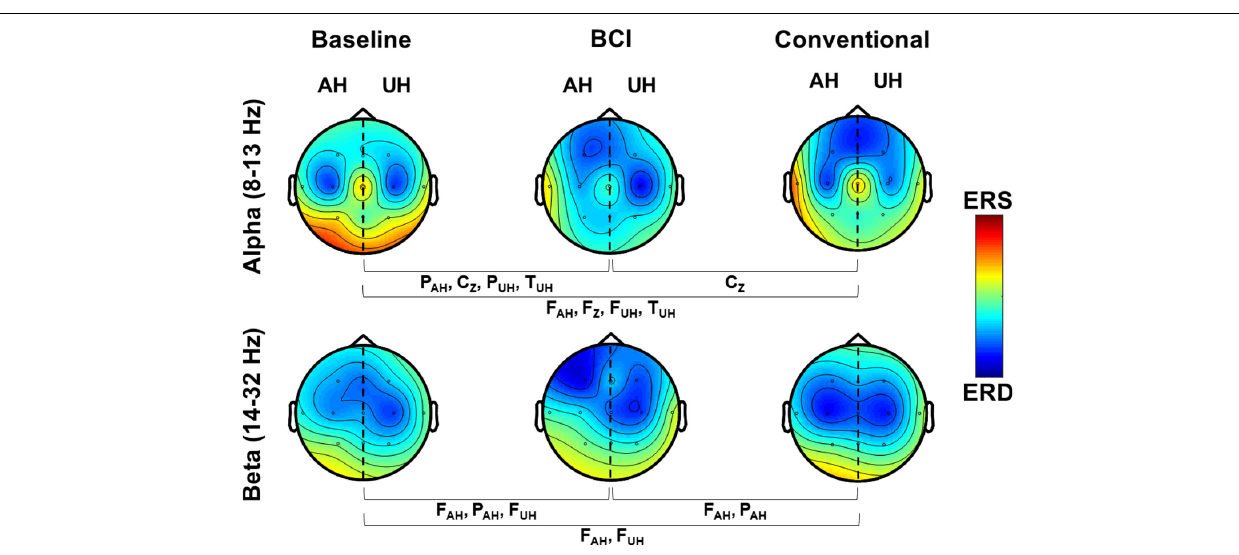
FIGURE 5 | MEP amplitude before and after each intervention. TMS elicited median MEP amplitude in patients’ affected (AH) and unaffected (UH) hemispheres, before and after the BCI and conventional therapies. Patients that did not present MEPs are not shown in the measurements.